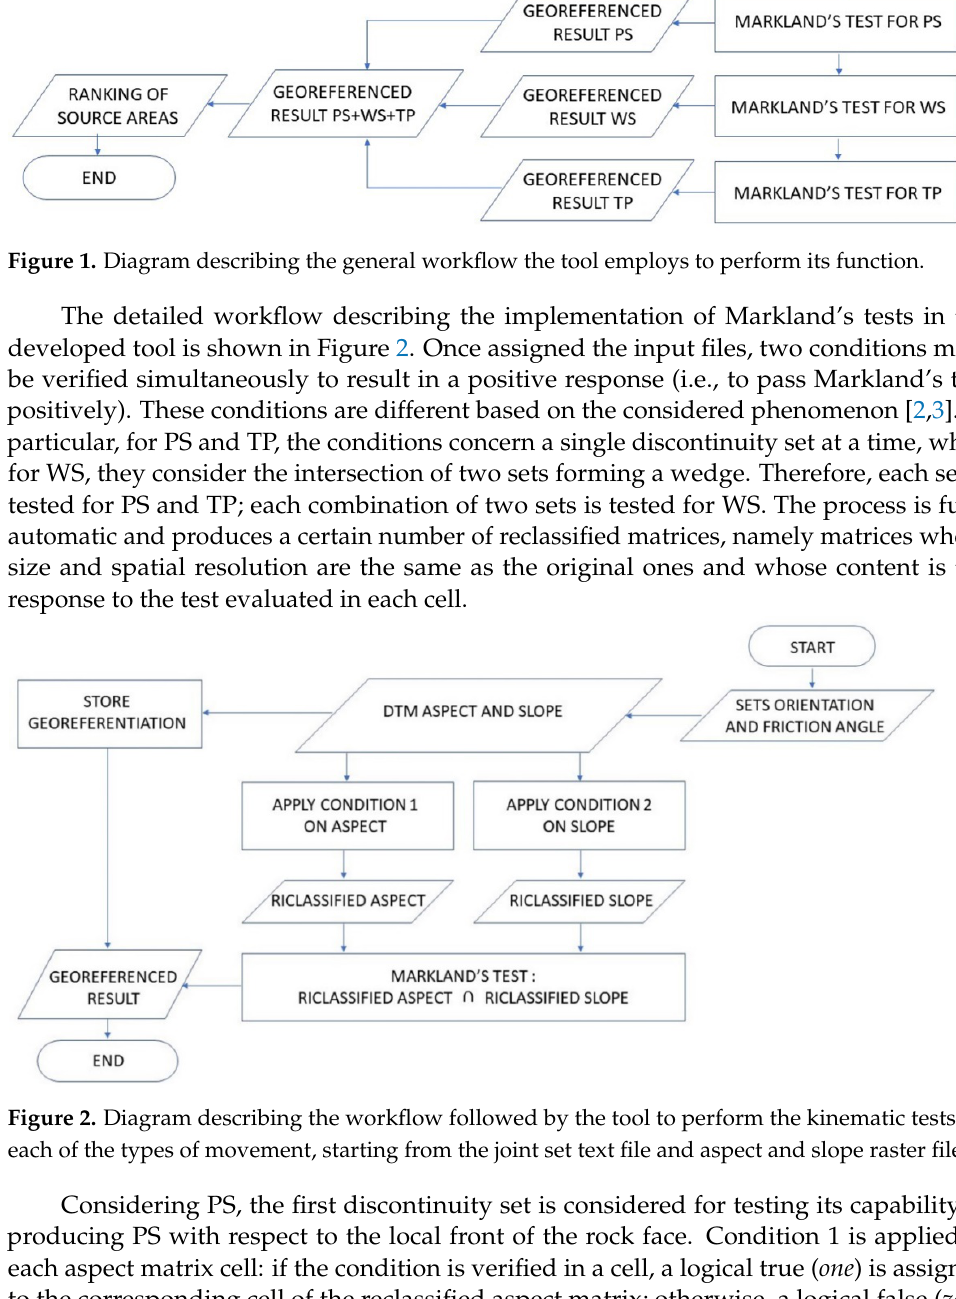
Figure 2. Diagram describing the workflow followed by the tool to perform the kinematic tests for each of the types of movement, starting from the joint set text file and aspect and slope raster files.